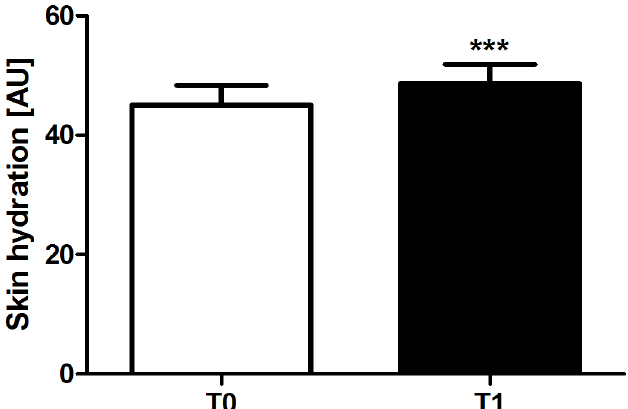
Figure 1. Skin hydration at baseline (T0) and after one application of the test product (T1) in the pilot study subjects. Data acquired using DermaView-PRO, a digital skin analysis photography system. *** indicates P <